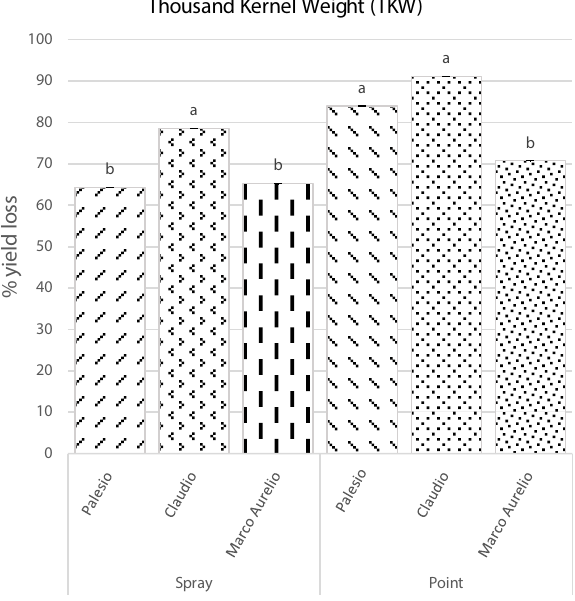
Figure 3. Fusarium graminearum biomass quantification from wheat chaff and rachides sampled from spikes that were either spray or point inoculated with 2,500 conidia per spike. Data repre- sents averages and standard errors for three independent technical replicates derived from three independent biological replicates for each genotype × inoculation method. Statistical analyses were per- formed according to two way analysis of variance (ANOVA), with Tukey test at 0.95 confidence level ( P < 0.05).